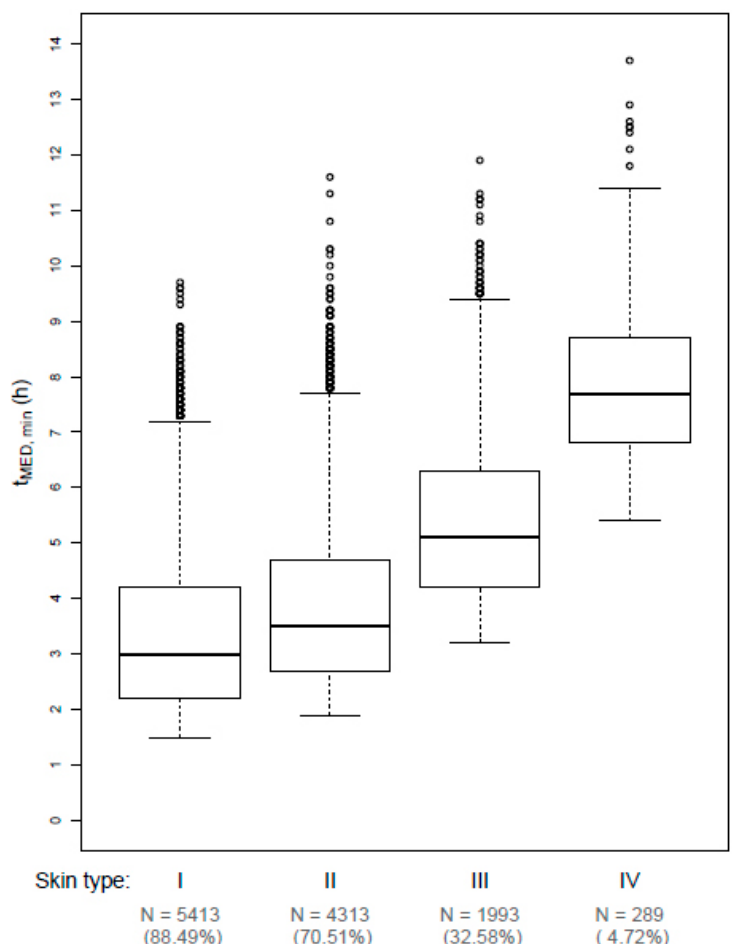
Figure 3. Boxplots of daily minimum exposure durations (in hours) needed to receive one MED (t MED, min ) for skin types I–IV for days with rounded UVI values of 1. Bold line: median, lower / upper edge of box: 25% / 75% quantile (first / third quartile), whiskers: range of data points which are no more than 1.5 times the interquartile range out of the box, dots: outliers. N (%) denotes the absolute (relative) number of observations in the subsample, i.e., the absolute (relative) number of UVI 1 days for which one MED could actually be received. The trend in t MED,min with respect to skin type can be considered significant ( p < 0.001).